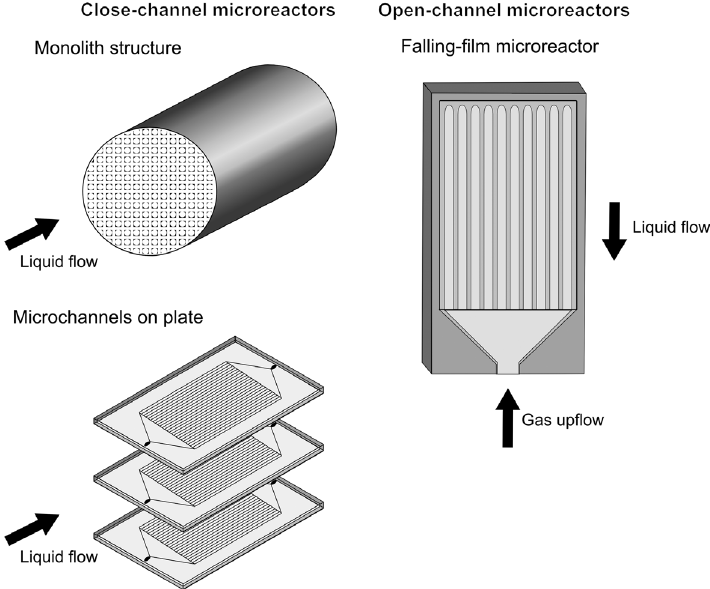
Figure 3 Microstructured elements widely used for phase contacting in microstructured flow